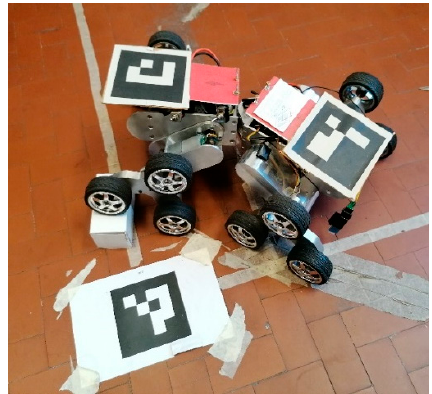
Figure 7. Epi.q mod2, the remotely controlled mobile robot used for testing the localization system with moving markers while climbing a little obstacle. The markers with ID 1 and 2 are fixed respectively on the front (left in the photo) and rear (right) module. The fixed reference (Marker ID 0) is fixed to the floor instead.